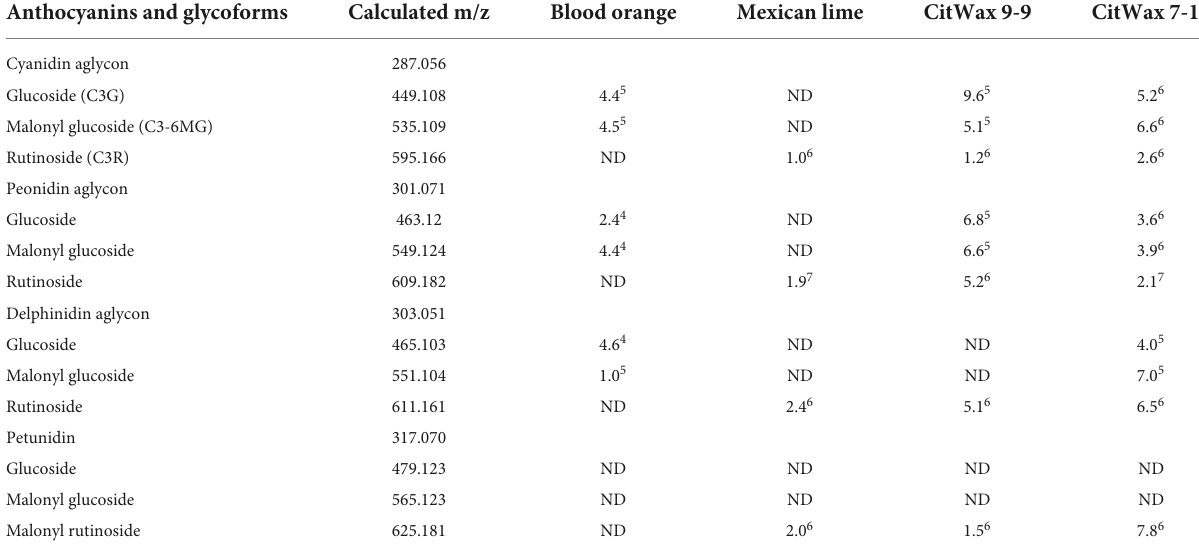
TABLE 2 MS-MS identified